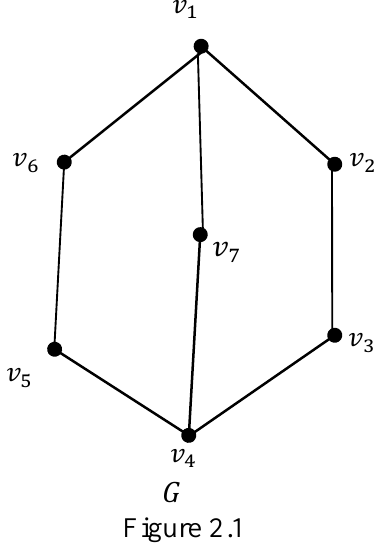
of Figure 2.1, 𝑆 -sets of 𝐺 so that 𝛾 𝑔𝑐𝑡